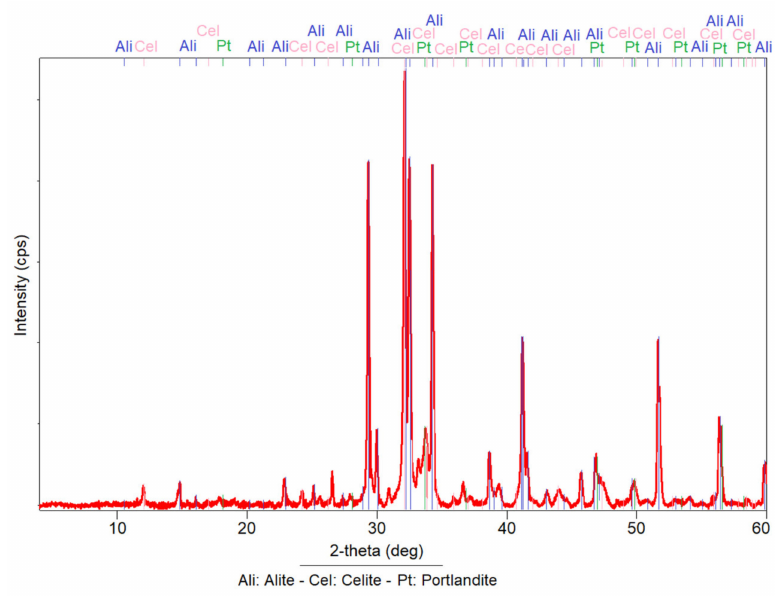
Figure 2. X-ray diffraction patterns of reference portland cement used in this